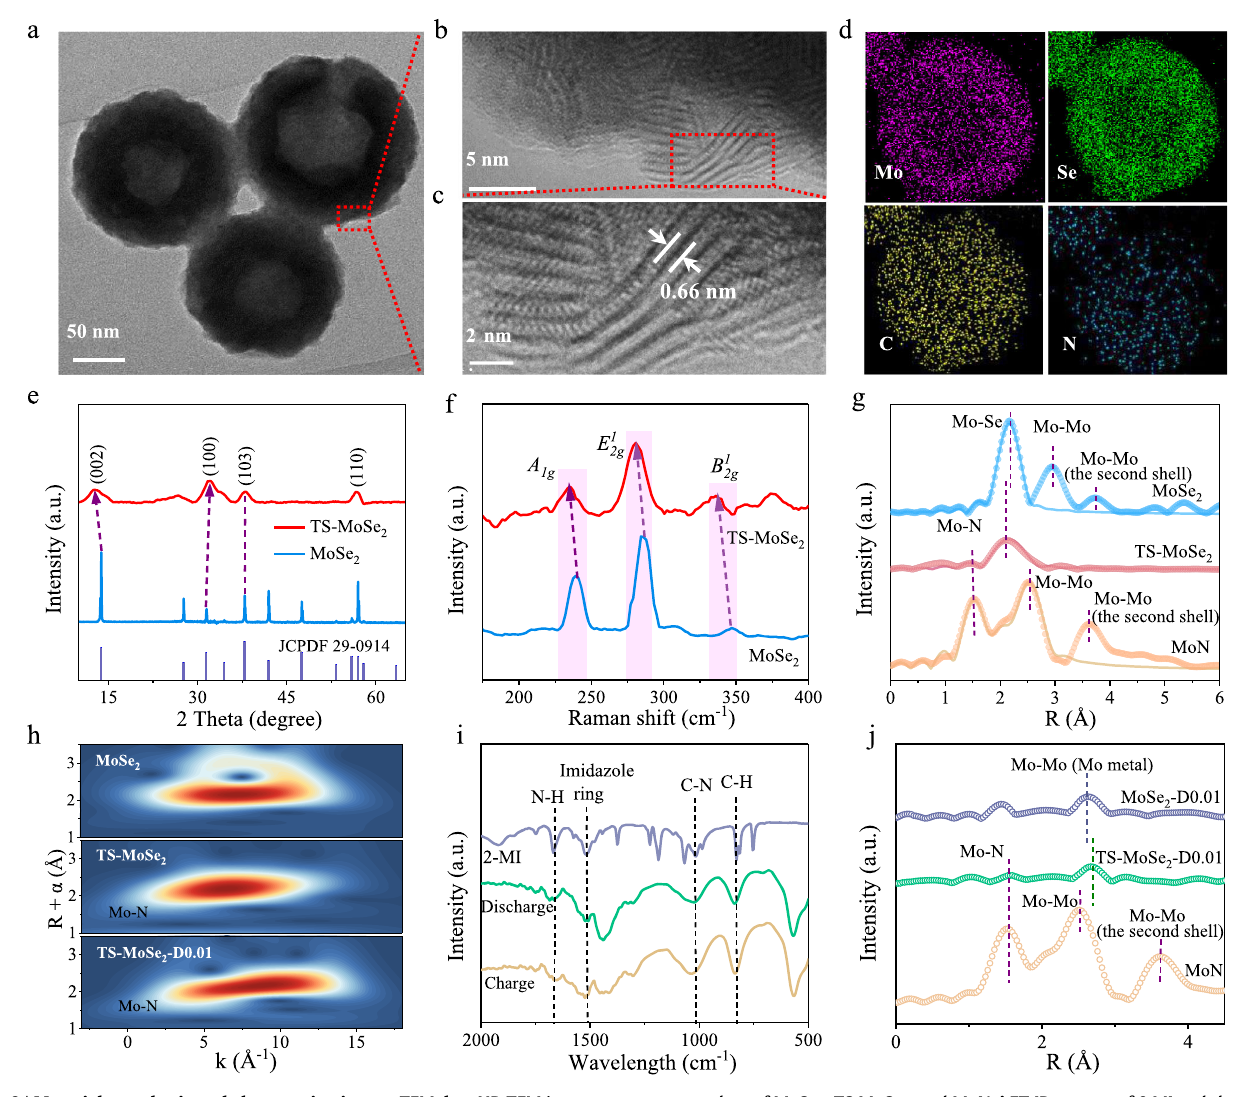
contour plots of MoSe 2 , TS-MoSe 2 , and MoN. i FT-IR spectra of 2-MI and the fully dischargedandchargedproductsofTS-MoSe 2 . j ThenormalizedMoK-edgeEXAFS spectra of MoN and the fully discharged product of TS-MoSe 2 (TS-MoSe 2 -D0.01) and MoSe 2 (MoSe 2